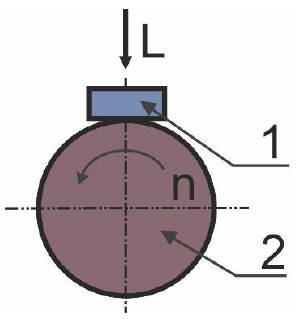
Figure 2. Schematic view of block-on-ring tester: 1—specimen, 2—rotating ring.